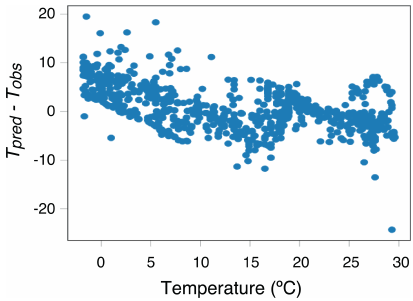
Figure 10. Temperature residuals for the forward model.